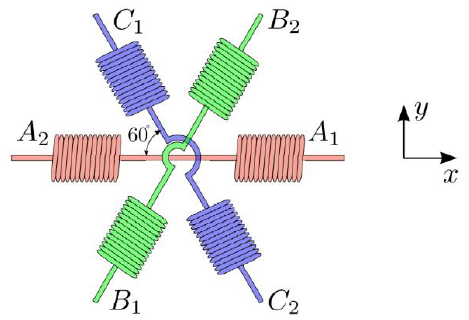
Figure 1. Spatial arrangement of the stator windings of a bearingless induction motor with split winding.